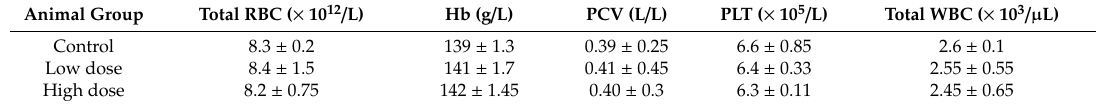
Table 5. Results of hemogram for test subjects (mean ± SD, n =